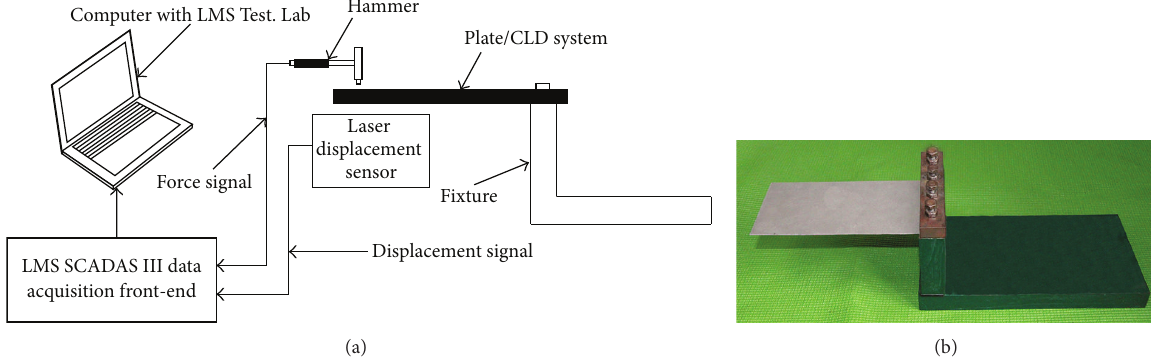
Figure 16: The experimental setup. (a) Schematic drawing. (b) The picture of the plate clamped in its fixture.